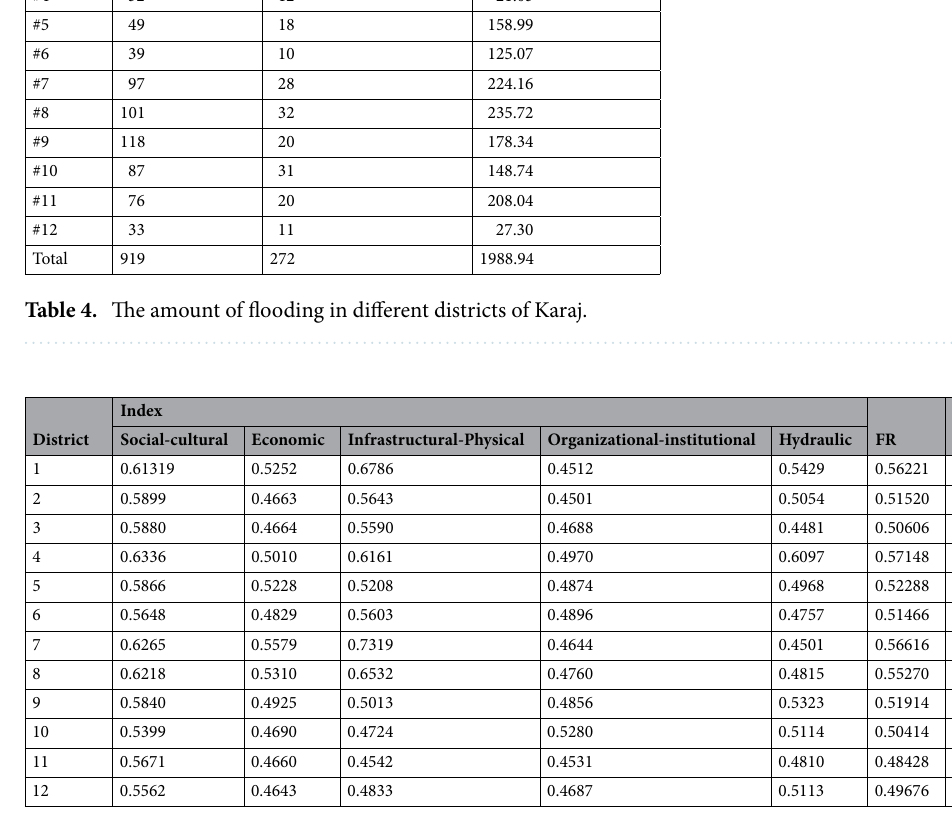
Table 5. Resilience indices in different districts and final FR values.